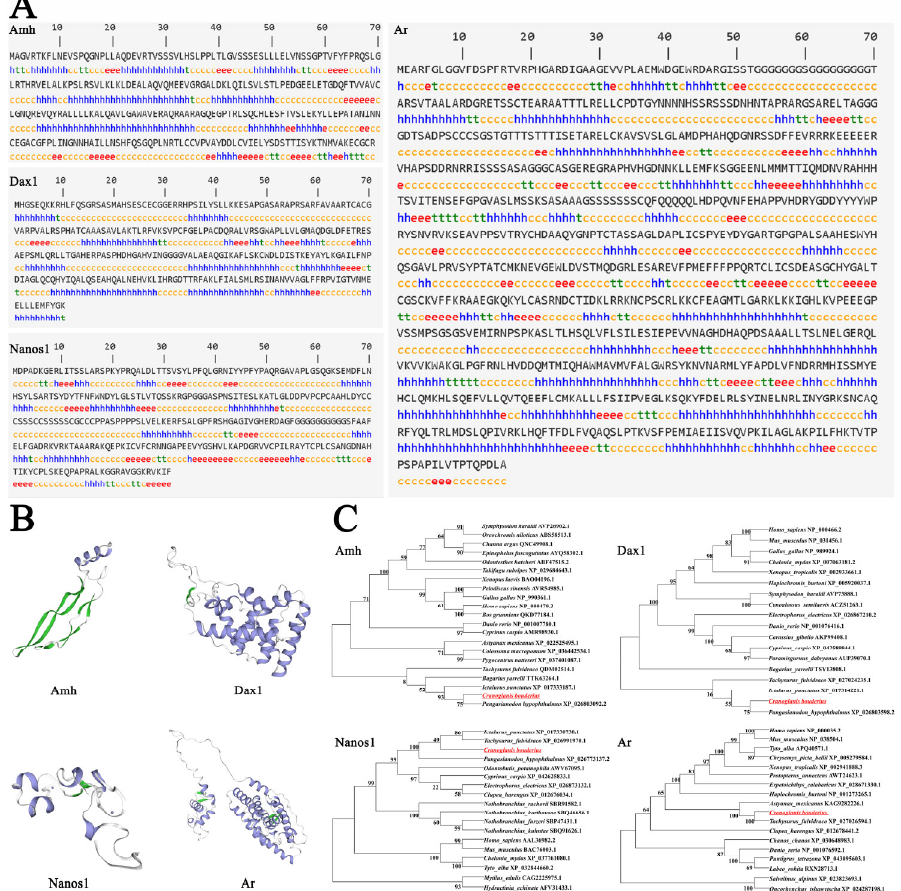
Figure 6. Secondary structure, tertiary structure, and phylogenetic tree of AMH, DAX1, NANOS1, and AR of C. bouderius . α-Helix(h), β-fold (e), β-Turning angle (t) and Irregular curl (c). and AR of C. bouderius . α -Helix(h), β -fold (e), β -Turning angle (t) and Irregular curl